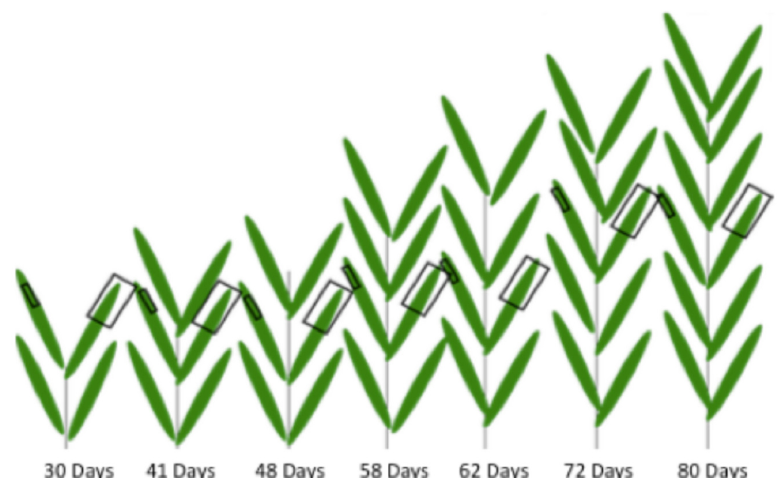
Figure 1. Conceptual diagram of the leaf sampling procedure. Each plant in the drawing represents 10 plants from one of seven developmental stages; the experimental design had n=10. Small squares represent SEM sampling areas and large squares represent ARISA sampling areas. All samples were taken from center leaves within each developmental group, and both samples per plant were taken from leaves of comparable position based on